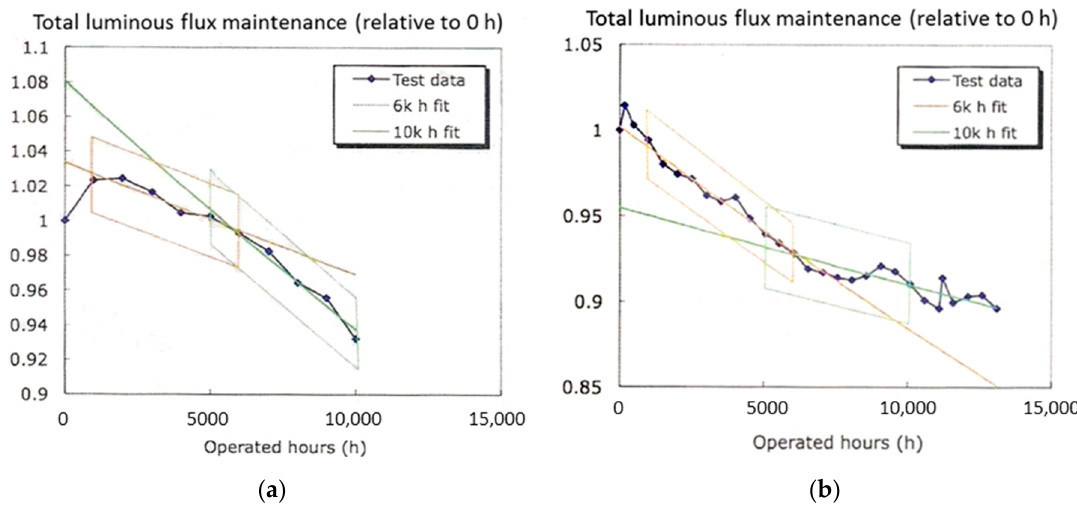
Figure 1. The change in aging trends: extrapolation of the 6k and 10k hours may differ dramatically (based on [49]) ( a ) L 70 (6k) = 60,000 h vs. L 70 (10k) = 30,000 h; ( b ) L 70 (6k) = 30,000 h vs. L 70 (10k) > 60,000 h.